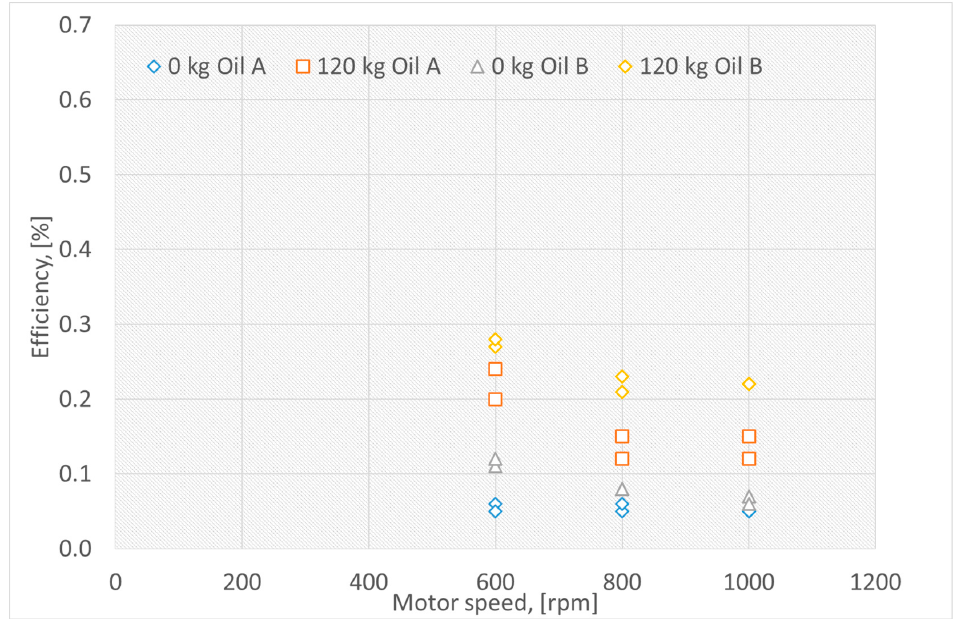
Figure 5. Measured data: DDH total system efficiency during lifting with various motor speed rpm and payload of 0 and 120 kg with oils A and B at ambient temperature − 10 °C.